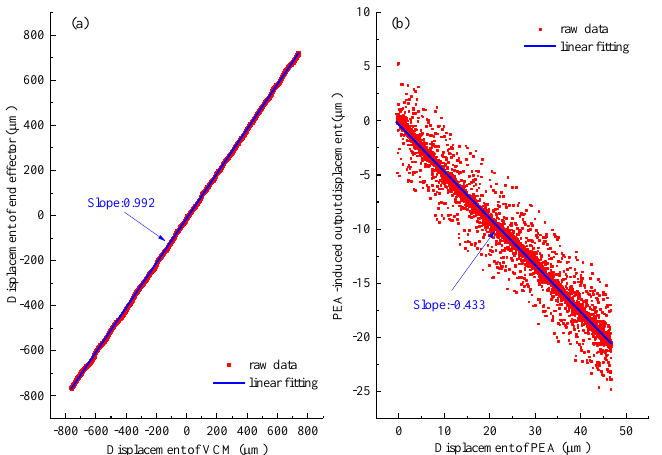
Figure 8. Kinematic test: ( a ) the displacement relationship between VCM and end effector while the displacement of the PEA is maintained at 0 µ m, and ( b ) the relationship between the PEA displacement and the PEA-induced output displacement.